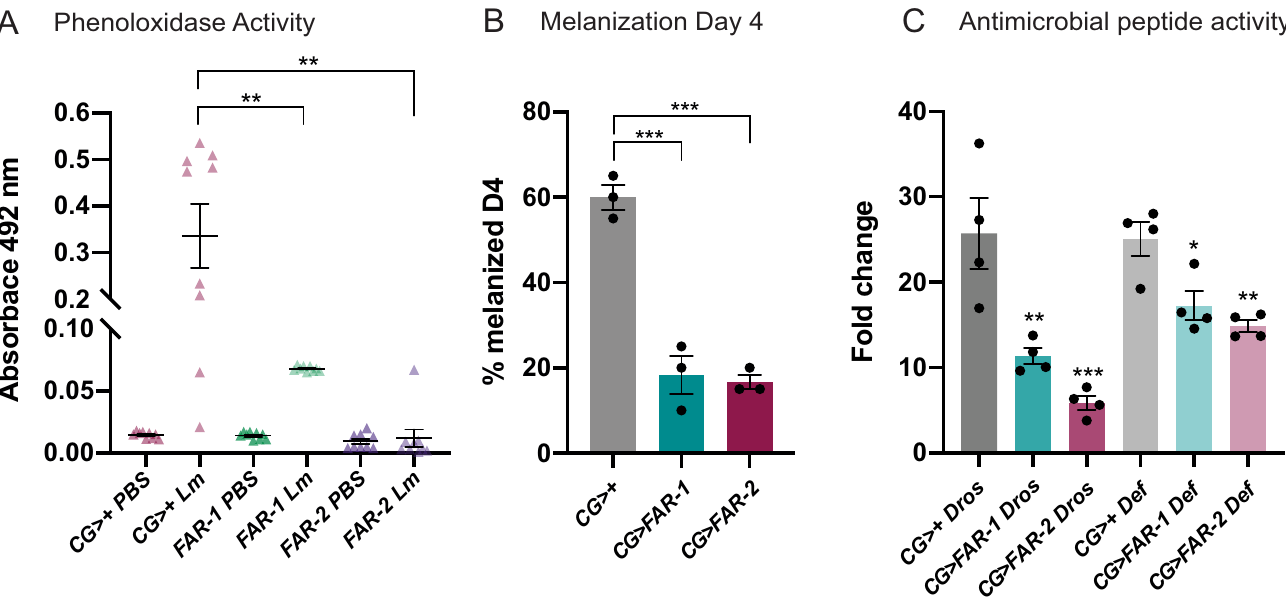
Fig 3. Melanization, phenoloxidase and antimicrobial peptide activity was diminished in FAR expressing flies. A) Flies were injected with the LD 30 of L . monocytogenes (1,000 CFUs) and phenoloxidase activity was measured 6 hours post-injection. B) Flies were injected with the LD 30 of L . monocytogenes and disseminated melanization was observed 4 days post-injection. C) 24 hours post-injection with the LD 30 dose of S . pneumoniae the relative increase in the antimicrobial peptides (AMP) Drosomycin (Toll) and Defensin (Imd) were analyzed. Compared to the CG > + control, FAR-1 and -2 significantly suppress both AMPs. Four experiments were completed with 15 flies per experimental group. Asterisks indicate statistical significance from one-way ANOVA (A & C) and unpaired t-test (B). All experiments were repeated at least 3 times, error bars show mean+SEM. All raw data available in supplemental